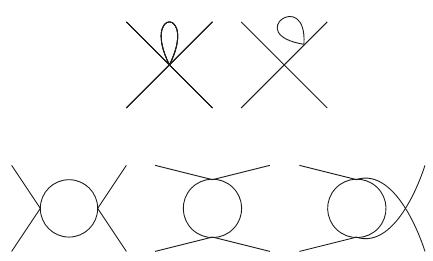
Figure 1 . Generic one-loop diagrams entering in meson-meson scattering. Top diagrams corre- spond to tadpoles, while bottom diagrams represent loops in the s , t , and u